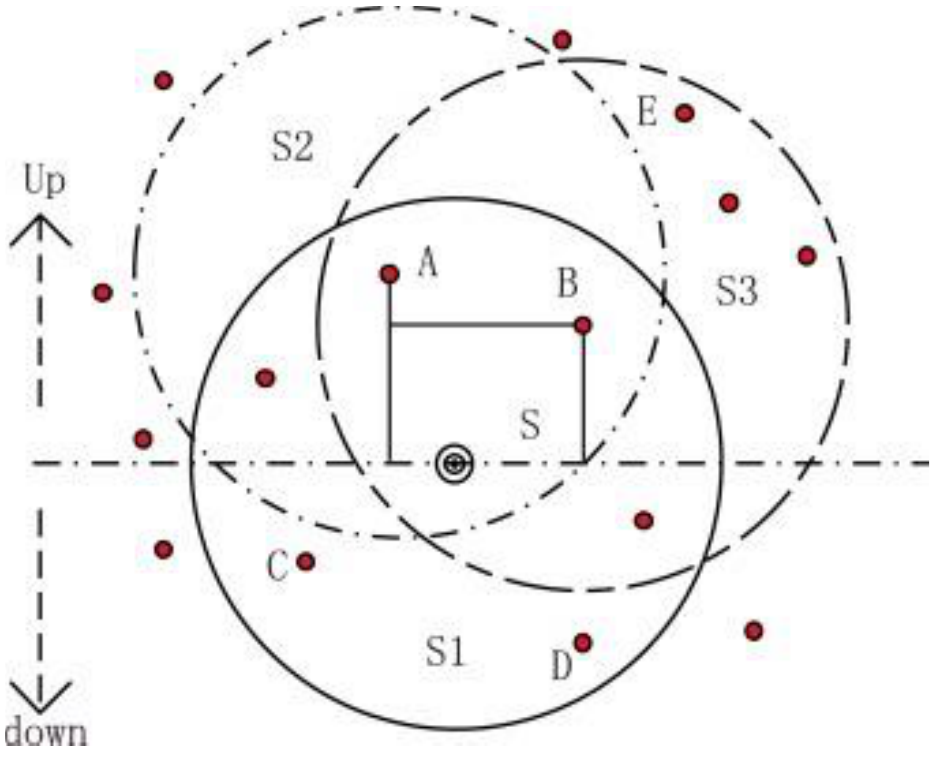
Figure 10. Void area problem